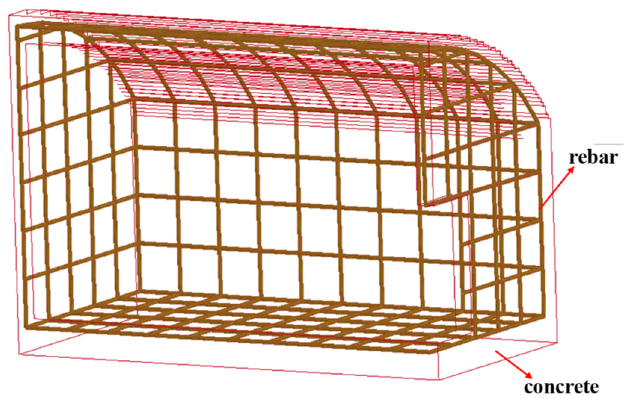
Figure 12. Model of the structure.